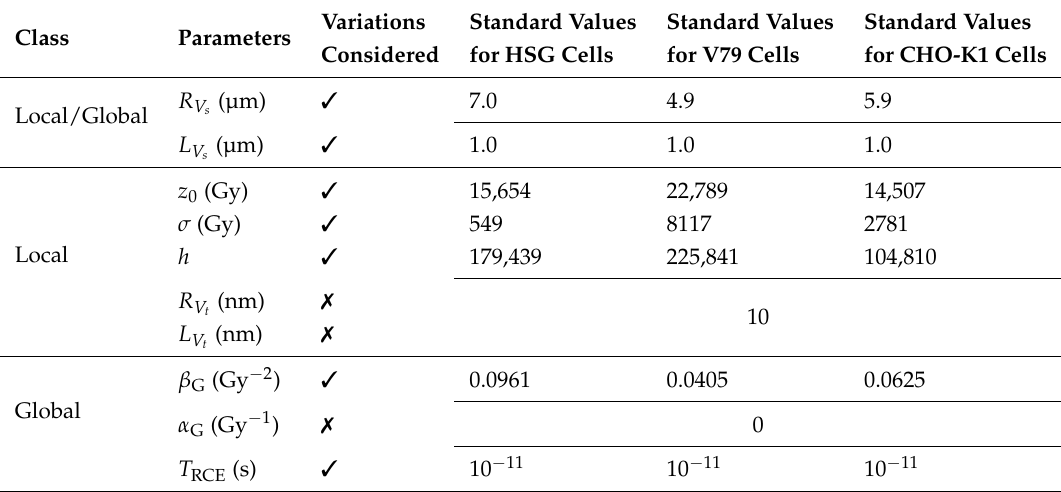
Table 1. Standard values of the parameters used to model the three cell lines with NanOx. R V represents the sensitive volume radius (length) and, similarly, R V radius